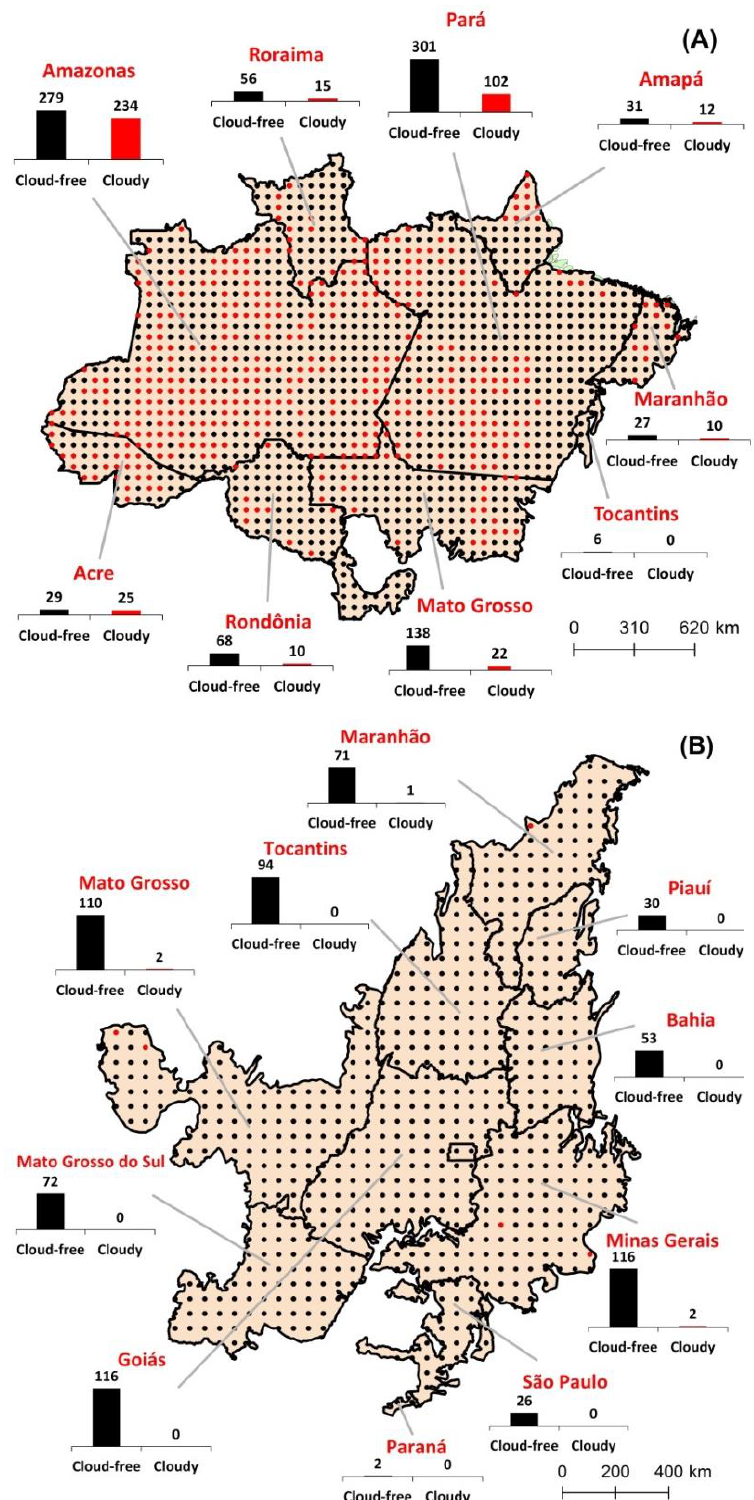
Figure 4. Landsat 8 OLI image sampling points per state predicted by the sampling design (confluence of 0.5 × 0.5 degree regular grid) and corresponding number of cloud-free Landsat 8 OLI images in the Amazon ( A ) and Cerrado ( B ) biomes. Red circles are the sampling sites without cloud-free images. Total number of cloud-free image sampling points: 929 for the Amazon biome and 690 for the Cerrado